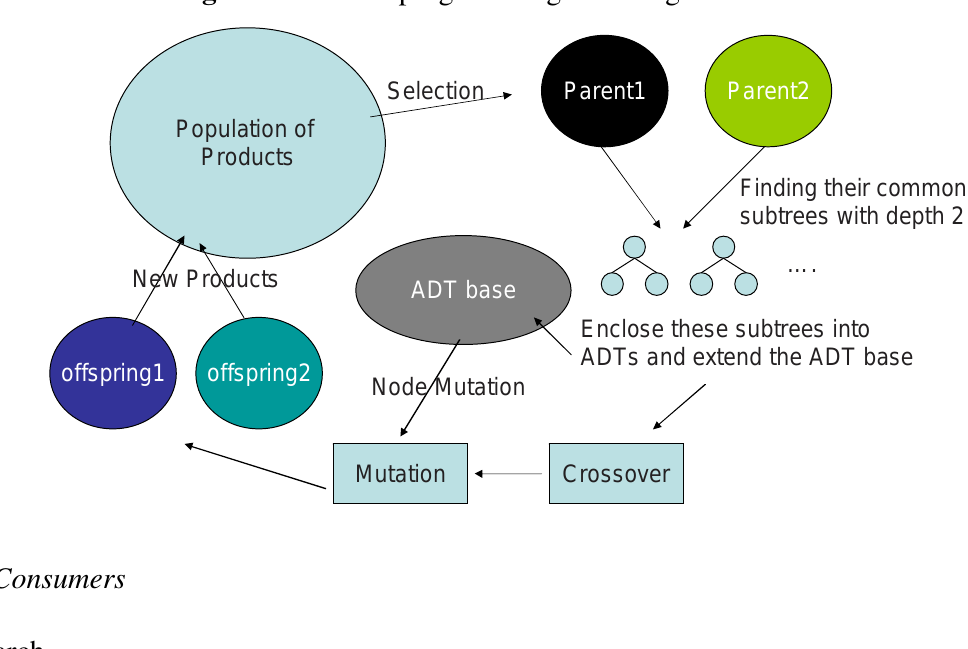
Figure 9. Genetic programming as an engine for